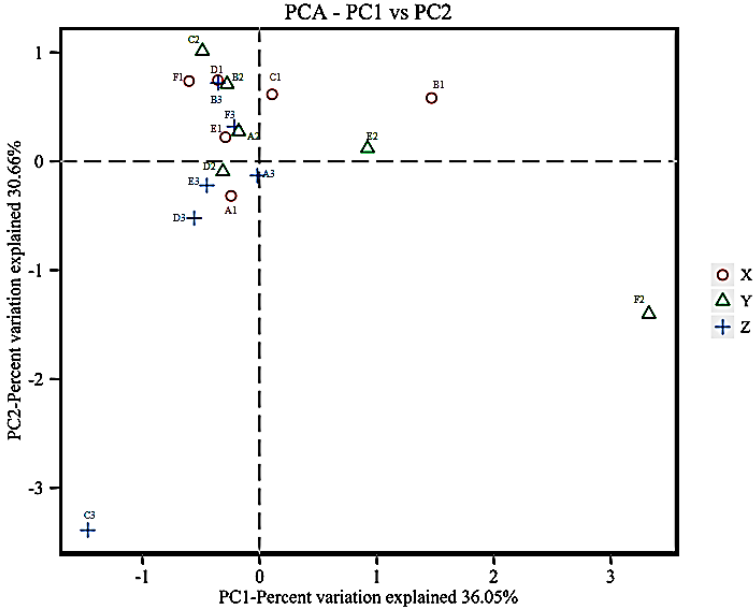
Figure 3. The PCA analysis of samples (cutoff = 0.03). X: April; Y: July; Z: October